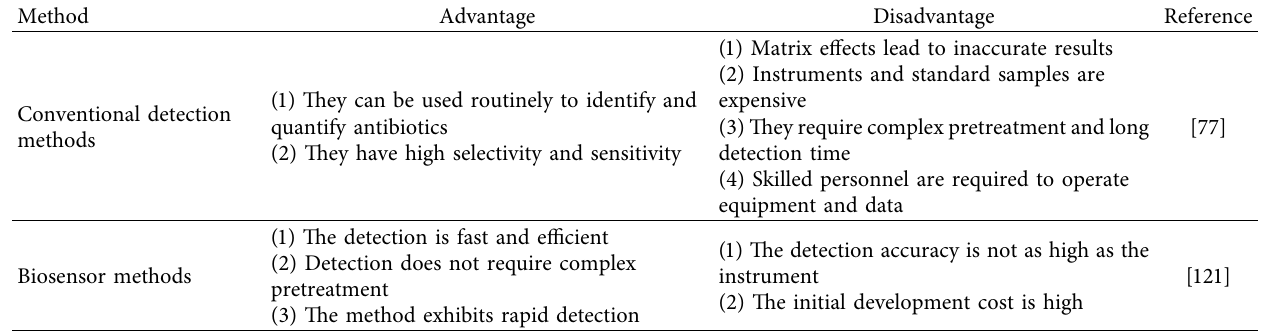
Table 4: A general comparison of different methods used for antibiotic